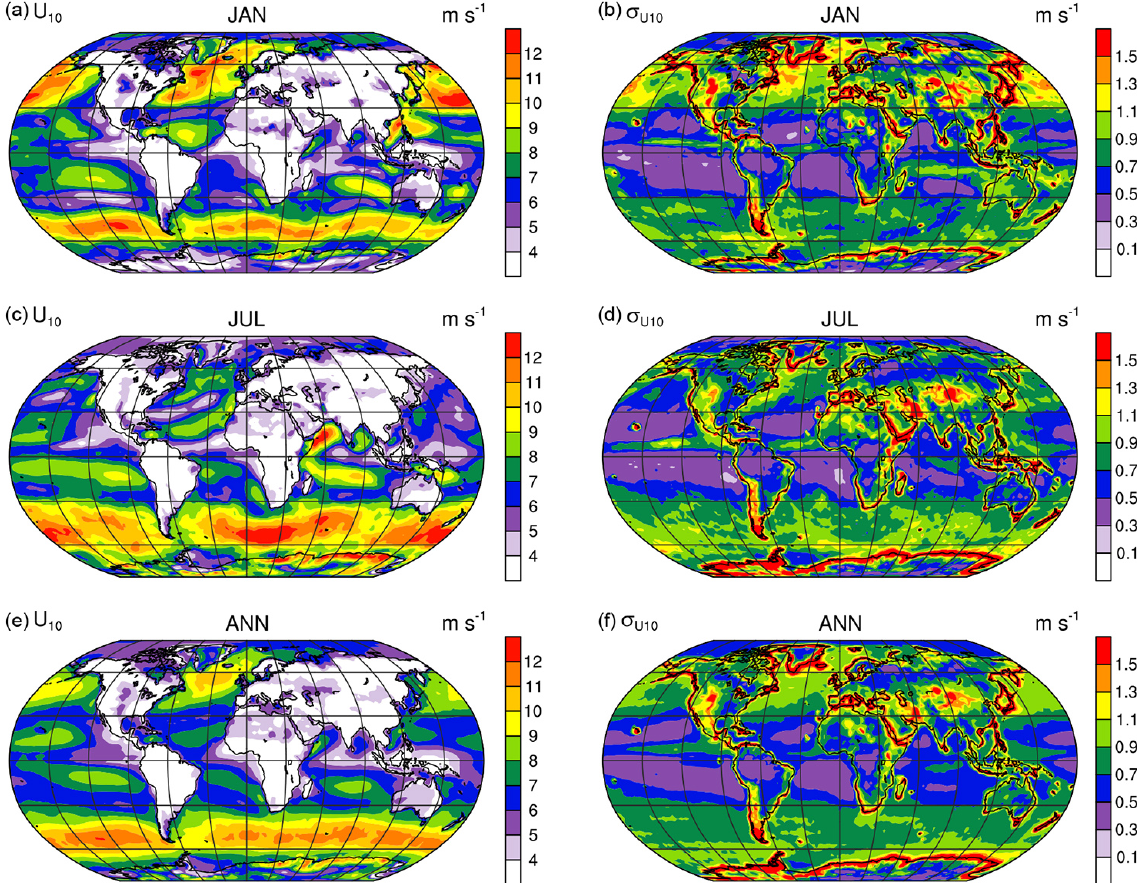
Figure 2. Grid-box average (left column) and sub-grid standard deviation (right column) of the 10m wind speed, diagnosed on an imagined 2 ◦ × 2 ◦ horizontal grid from the ECMWF 15km global analysis of the year 2011. From top to bottom: January average, July average, and annual mean. See Sect. 3 for further